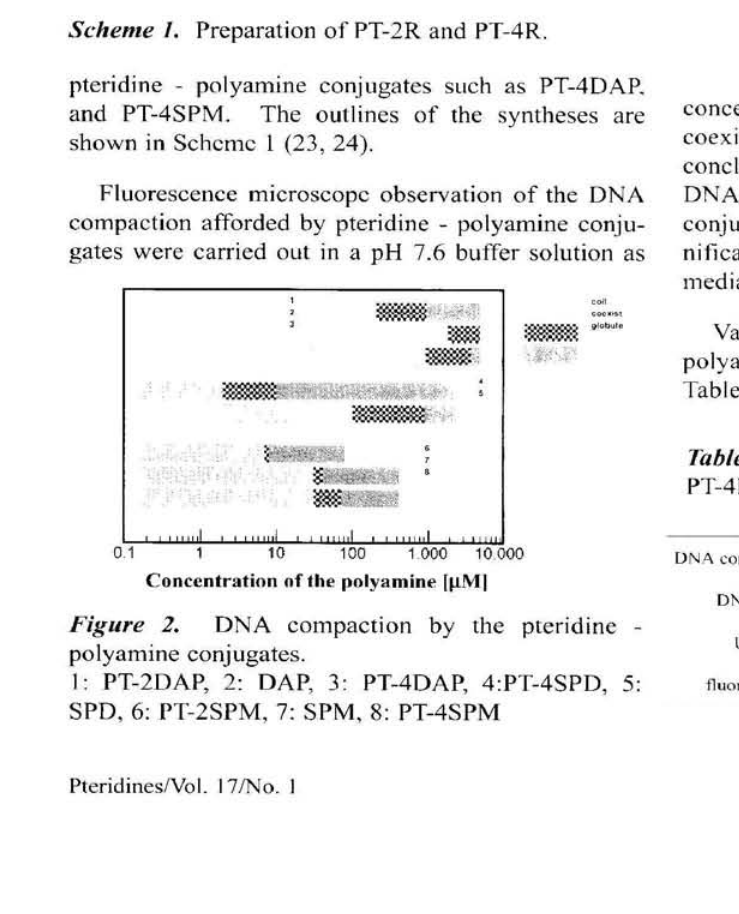
Figure 2. DNA compaction by the pteridine - polyamine conjugates.